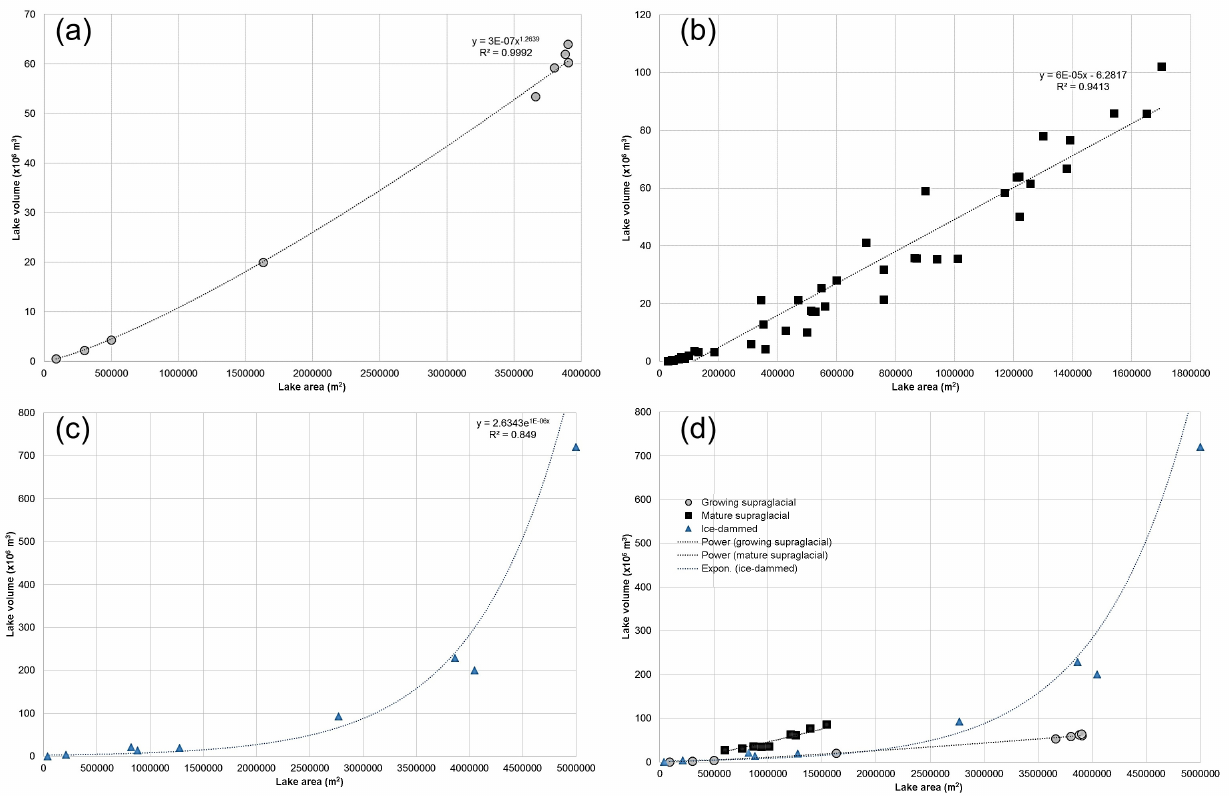
Figure 3. Plots of lake area–volume data according to different lake dynamic contexts: (a) growing supraglacial lakes; (b) moraine-dammed lakes excluding the largest lakes (Nef, Leones, Tasman) and extreme outliers (Ngozumpa 4) to facilitate comparison with the conceptual model presented in Fig. 4; (c) ice-dammed lakes; (d) growing supraglacial lakes compared to ice-dammed lakes and a selection of moraine- dammed lakes (labelled here as “mature supraglacial lakes”). Note that growing supraglacial lakes form a distinct population compared to other lake